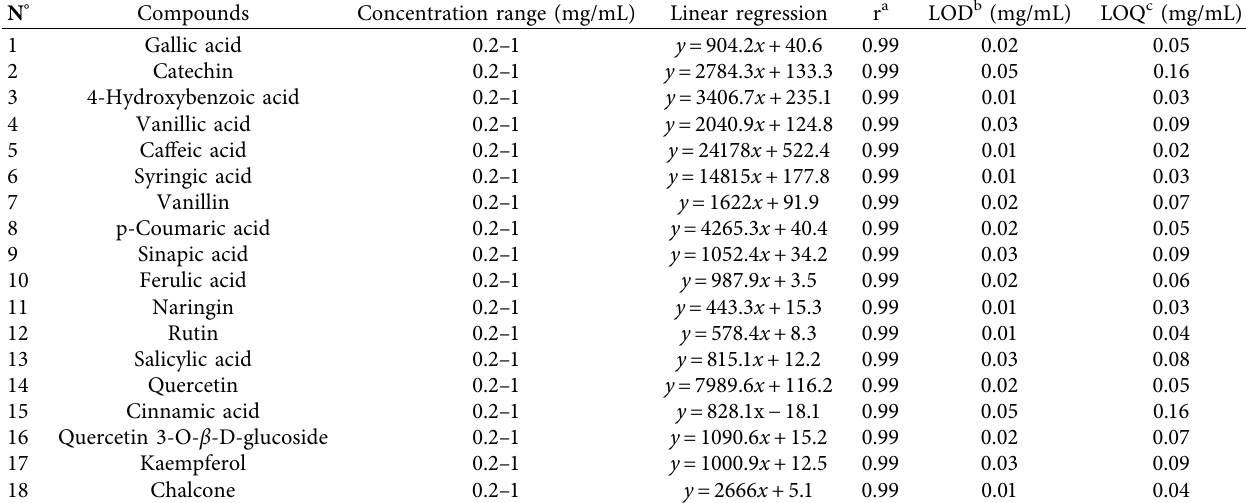
Table 1: Linearity of phenolic compounds standards and sensitivity of the HPLC-DAD method. N ° Compounds Concentration range (mg/mL) Linear regression r a LOD b (mg/mL) LOQ c